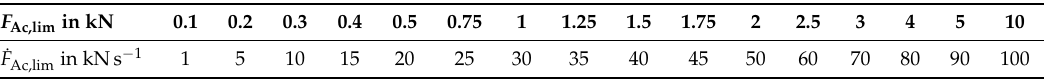
Table 7. Actuator limitations (input constraints) for the stochastic road-profile scenario. F Ac,lim in